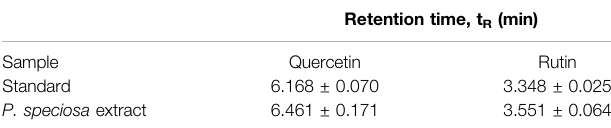
TABLE 1 | Retention time (t R ) of quercetin and rutin in 10 mg Parkia speciosa crude extract compared to standard